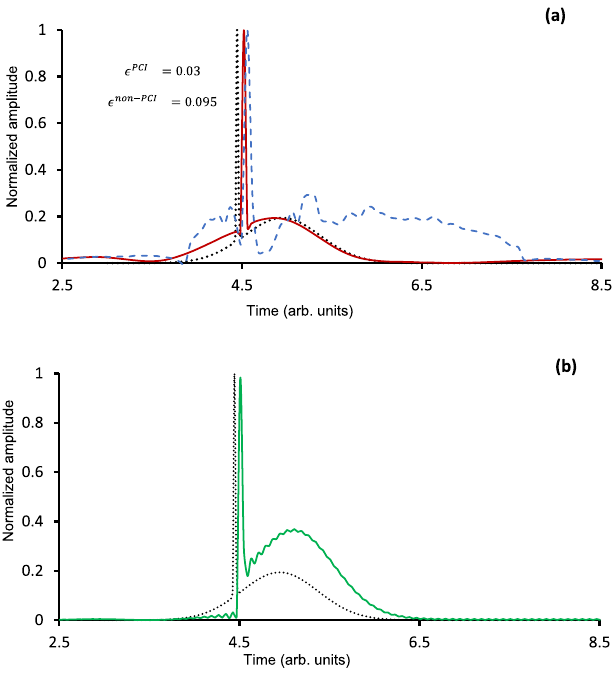
FIG. 3. As in Fig. 2 but with A 1 ¼ 1 ; A 2 ¼ 0 . 02 ; σ 1 ¼ 0 . 0085 ; σ ¼ 0 . 425 ; t ¼ 0 . 043 ; t ¼ 0 . 543 . The reconstructions are 2 1 2 based on: (a) a non-PCI (dashed blue line) and the PCI (solid red line) algorithms; (b) Kramers-Kronig (minimal phase) pro- cedure (solid green line). The black dotted line shows the original